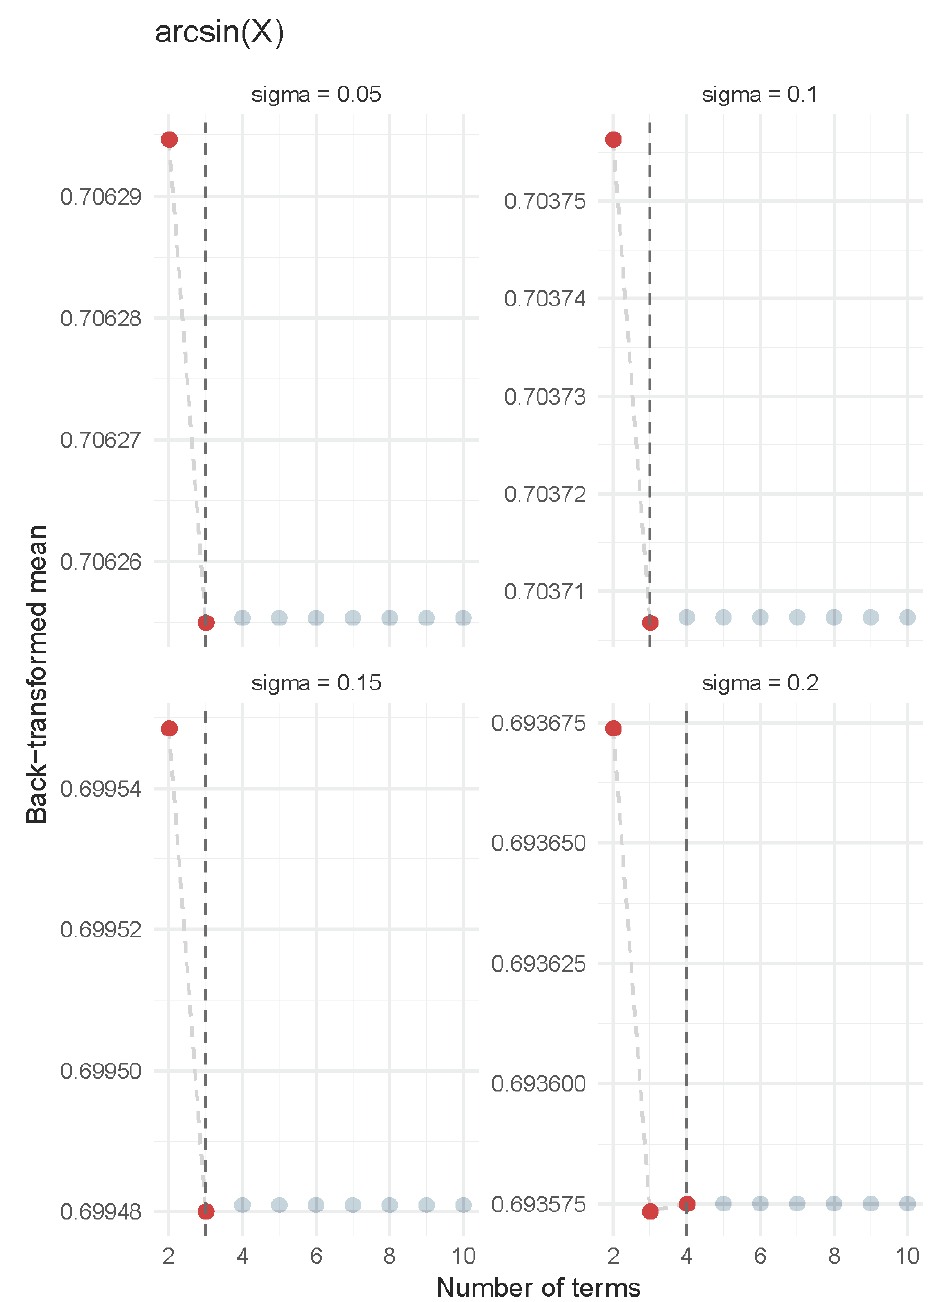
Figure 4. Convergence of the arcsine transformation according to the number of terms in the Taylor series expansion. The vertical dotted line identifies the number of terms for which two consecutive differences between Taylor series estimates are less than the preset value of the order of 10 − 5 .